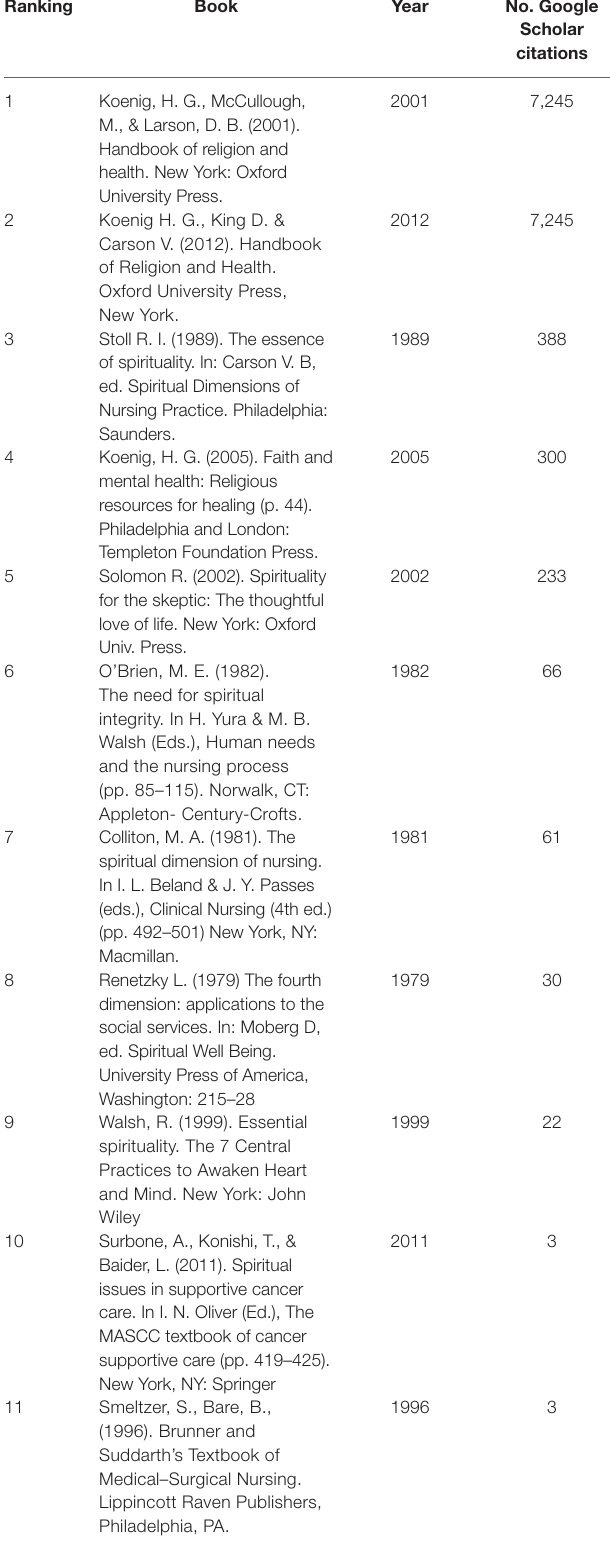
TABLE 2 | Most cited books, according to Google Scholar citations in November 3, 2020, found in the present study.